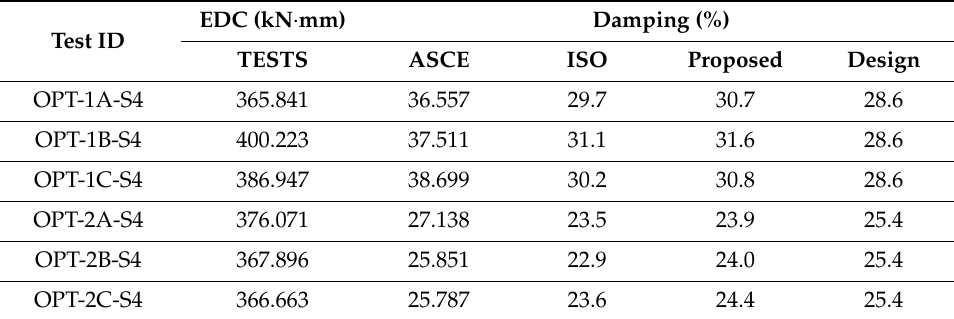
Table 8. Results of equivalent viscous damping ratio (D = ± 35